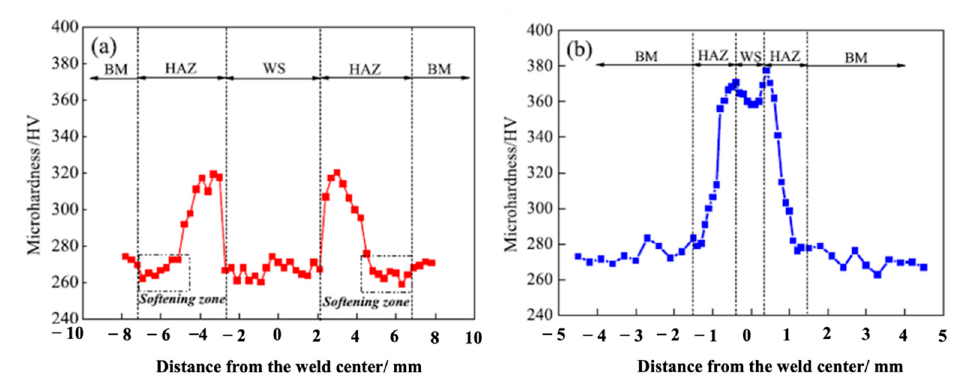
Figure 9. Microhardness variation in ( a ) GMAW and ( b ) laser welding. Reprinted with permission from ref. [34]. Copyright 2016, Elsevier.